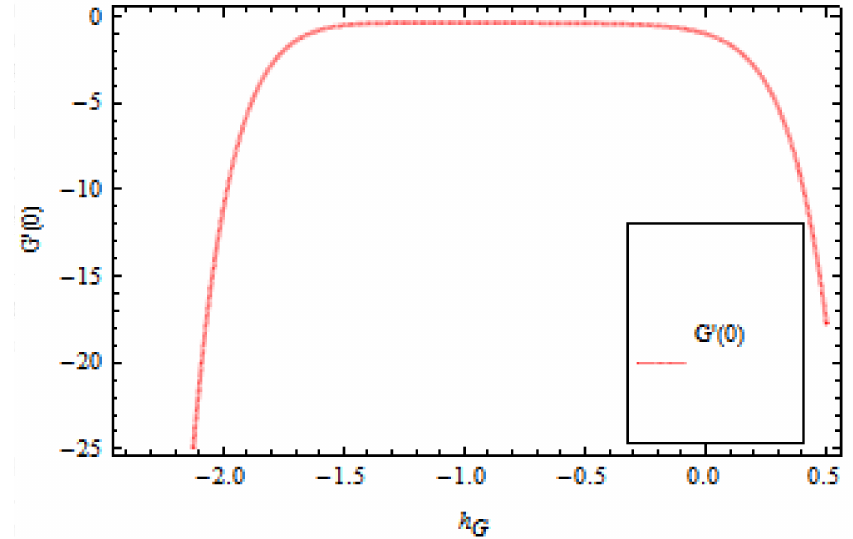
Figure 3. The (cid:125) -curve graph of temperature profile, when Pr = 0.5, K = 0.5, Rd = 0.5, λ = 0.5, κ = 0.5, γ = 0.5, Sin τ = 1.0, A =